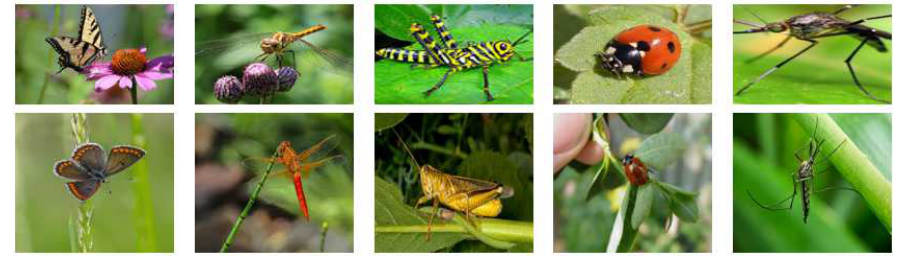
Figure 7. Some insect images extracted from the